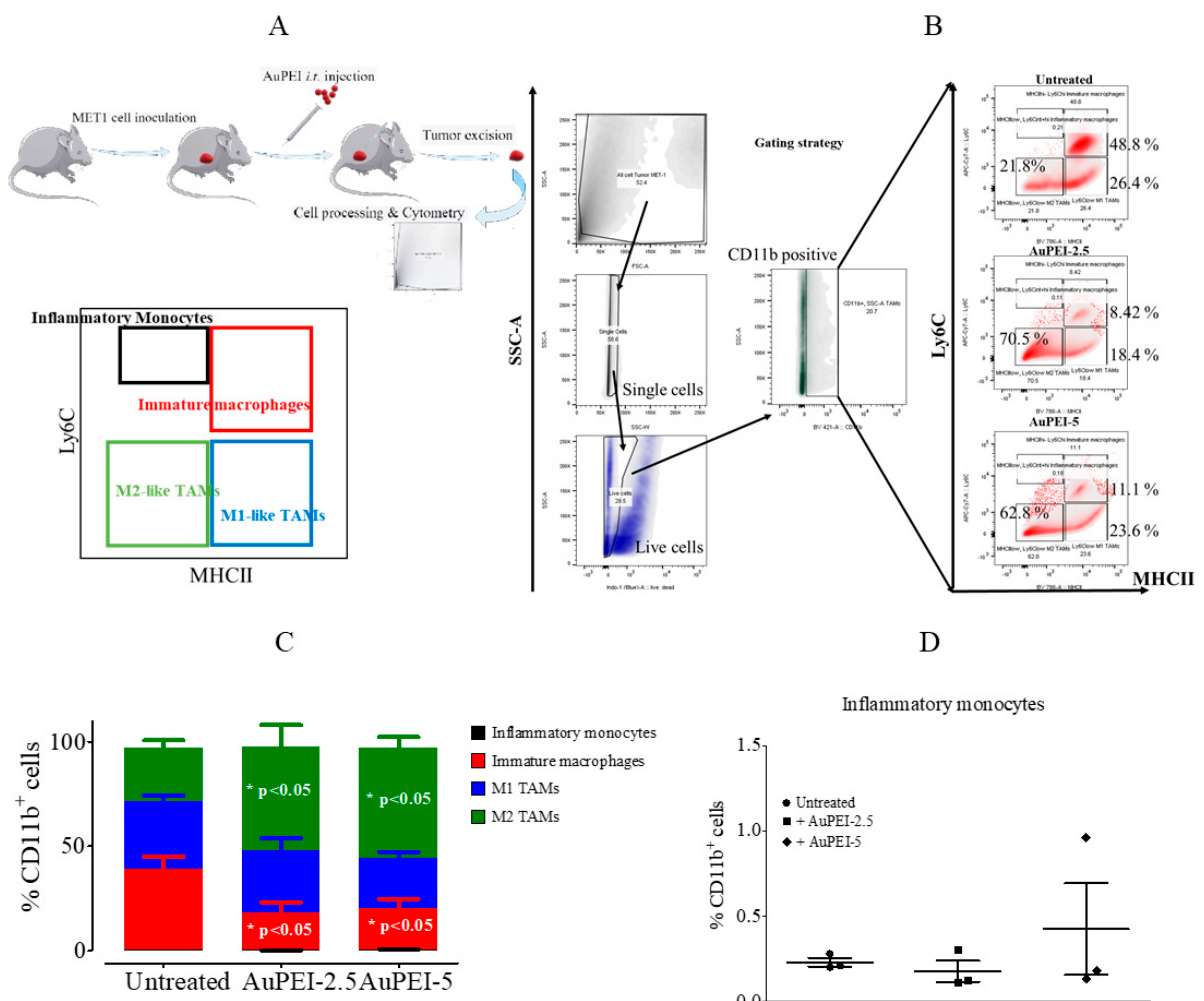
Figure 3. MET-1-infiltrating tumor-associated macrophage (TAM) distribution upon AuPEI nanocom- posite i.t. injection. MET-1-bearing mice were injected i.t. with 40 µL of 0.5 mg/mL AuPEI nanocom- posites and euthanized 24 h after. ( A ) Experimental procedure and gating strategy to differentiate TAMs within the tumor cell population. Inflammatory monocytes defined as CD11b + MHCII − Ly6C hi ; immature macrophages defined as CD11b + MHCII hi Ly6C hi ; M1-like tumor-associated macrophages de- fined as CD11b + MHCII hi Ly6C − ; and M2-like tumor-associated macrophages defined as CD11b + MHCII − Ly6C − . ( B ) A representative dot-plot shows the percentage of different TAM populations upon AuNP nanocomposite injection and ( C ) summary of TAM distribution. ( D ) Distribution of inflam- matory monocytes within tumor nest. (Results are shown as mean ± SEM of n = 3 per condition; * p < 0.05 Mann–Whitney test, 95% confidence).